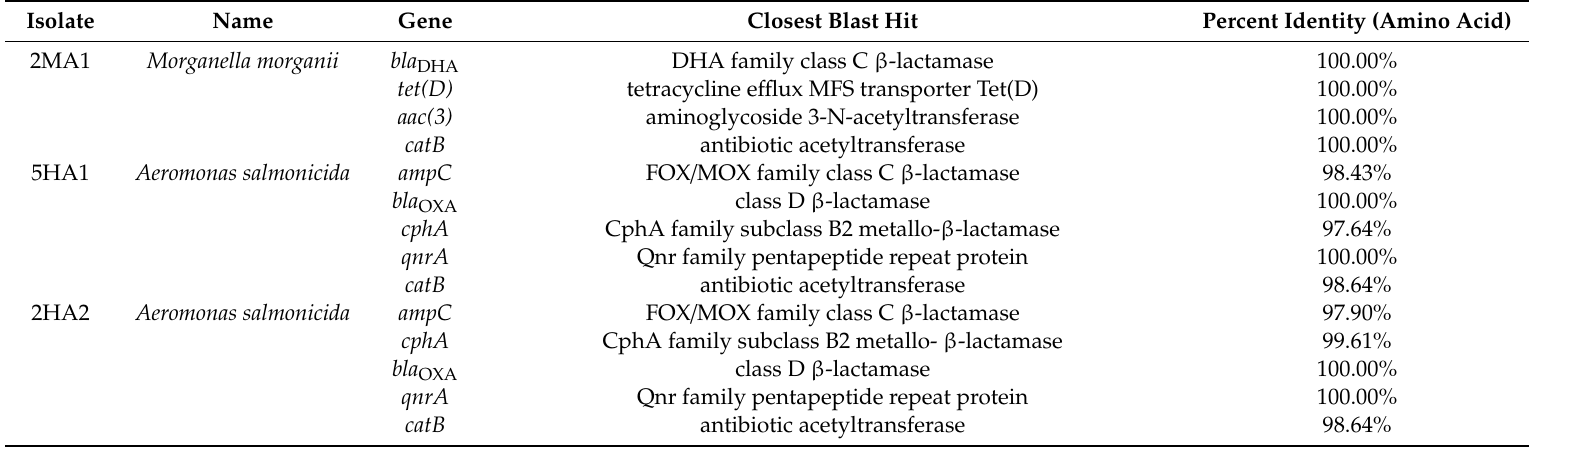
Table 2. Overview of the di ff erent antibiotic resistance genes (ARGs) detected in whole genome sequence of the isolates.